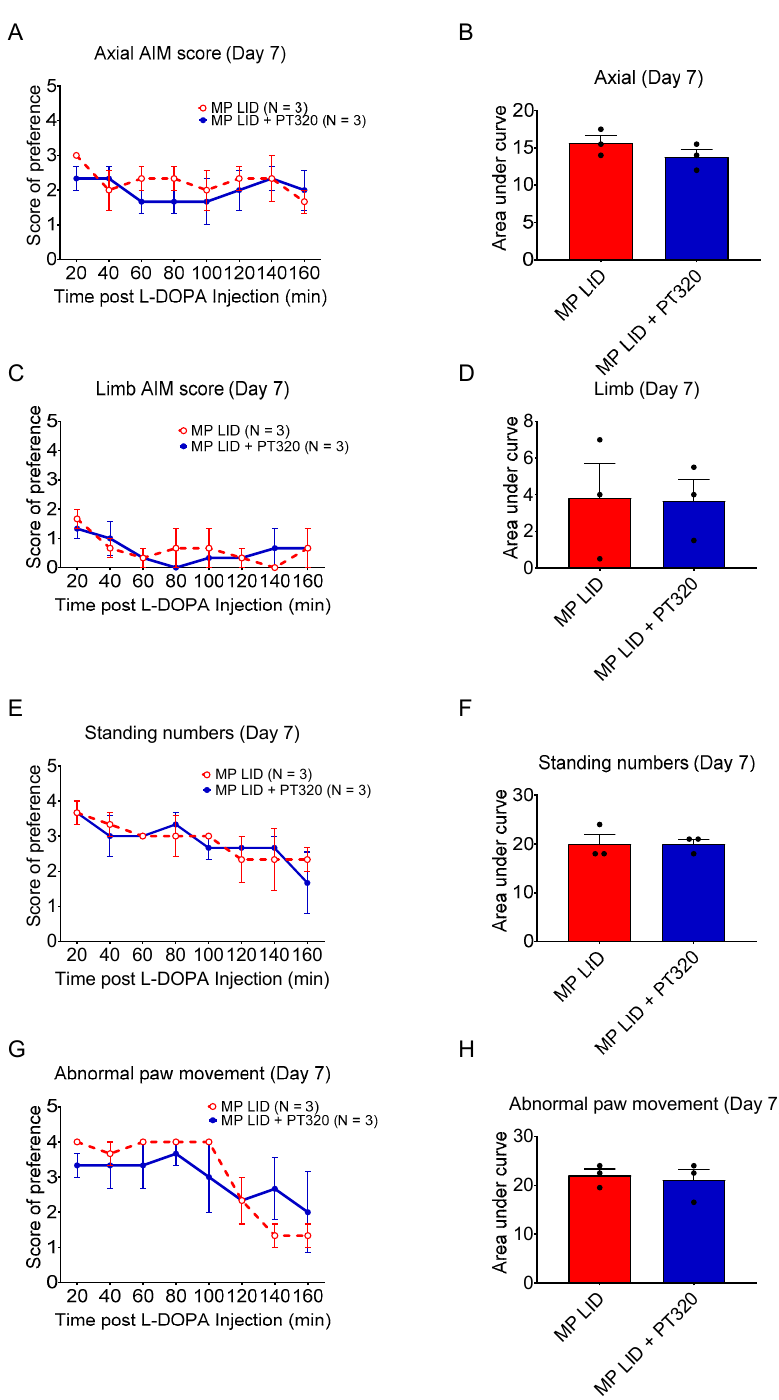
Figure 7. AIM scores on day 7 of induction protocol in the late treatment group. The AIM scores recorded on day 7 of the induction protocol for the late treatment group show no significant difference in ( A ) axial deviation, ( C ) limb abnormal movement, ( E ) standing and ( G ) abnormal paw movement after levodopa injection the between late PT320 treatment group and the non-treatment group. The areas under the curve of each item also showed no significant differences between the groups ( B , D , F , H